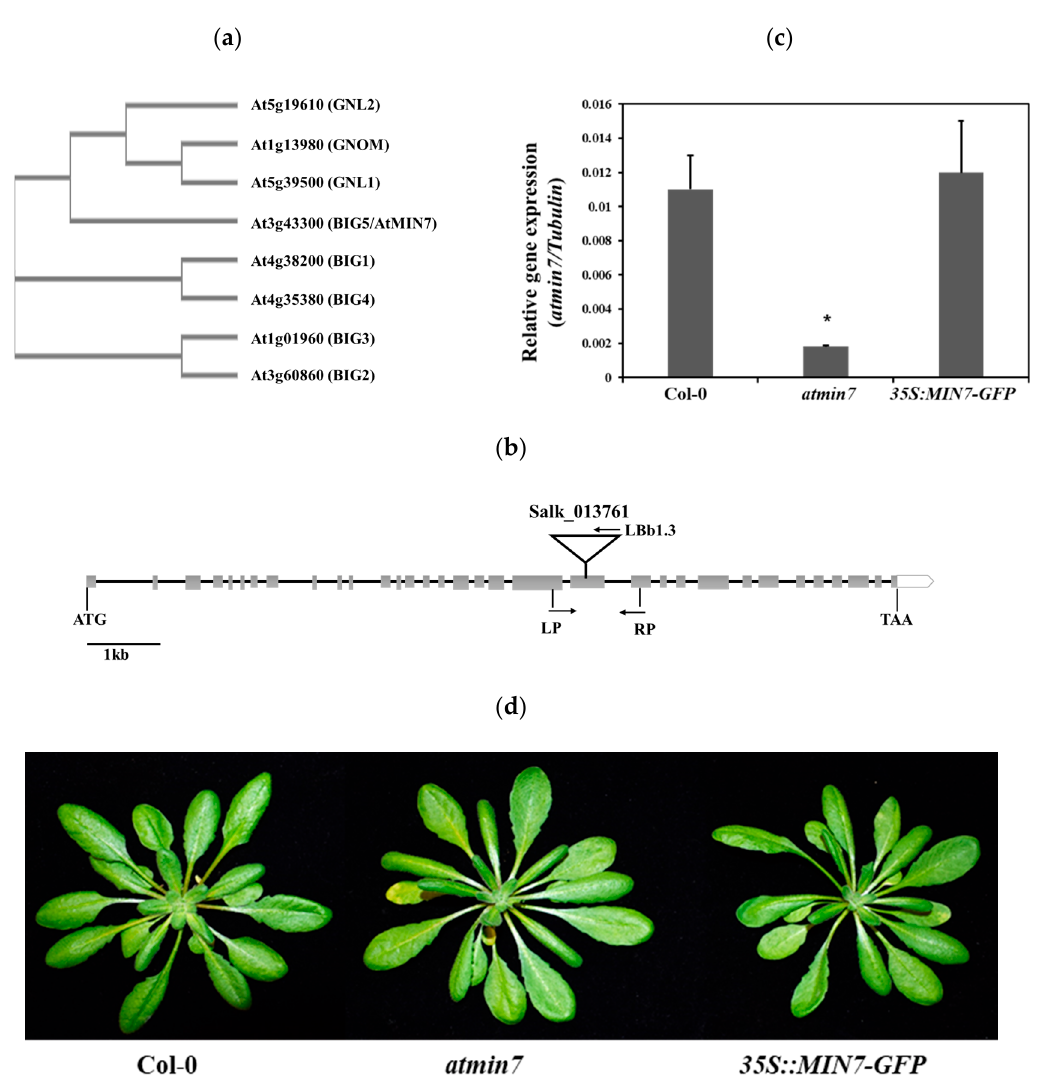
Figure 1. Characterization of the atmin7 mutant. ( a ). Phylogenetic analysis of the ARF-GFF protein family in Arabidopsis . ( b ). Schematic representation of the T-DNA insertion site in atmin7 mutant. Heavy black lines and gray rectangles indicate introns and exons, respectively. The T-DNA insertion site for Salk_013761 is shown. The position and orientation of primers used for qRT-PCR are indicated. ( c ). Relative AtMIN7 transcript abundance in the WT, atmin7 , and 35S::MIN7-GFP plants. The experiment was repeated three times with similar results and the mean +/- SD for the combined data from three replicates are shown. Unpaired two-tailed Student’s t -tests with WT plants indicated that the transcript level of AtMIN7 was significantly reduced in atmin7 but not 35S::MIN7-GFP (* p < 0.01). ( d ). Morphological phenotype did not differ between vegetative rosettes of four-week-old WT, atmin7 , and 35S::MIN7-GFP plants.